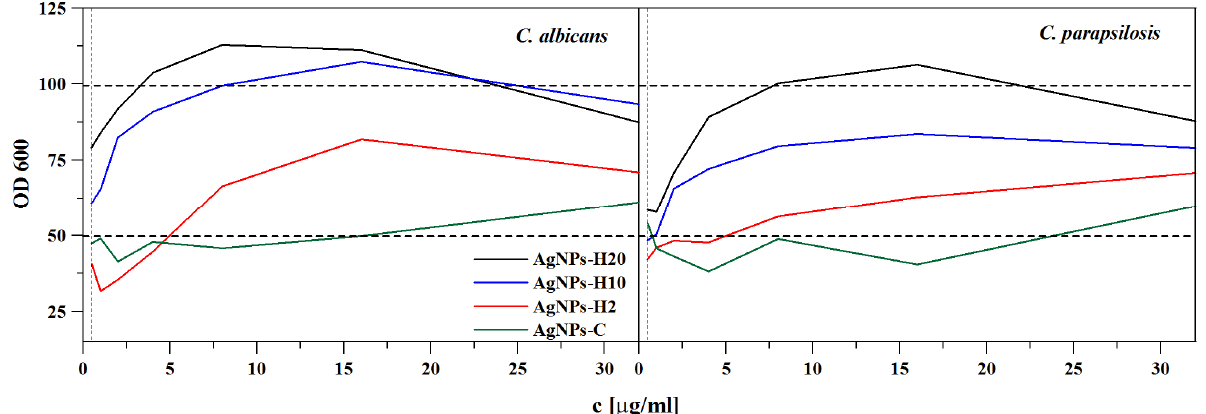
Figure 4. Optical density (OD) at 600 nm as a function of the silver nanoparticle AgNP concentration.